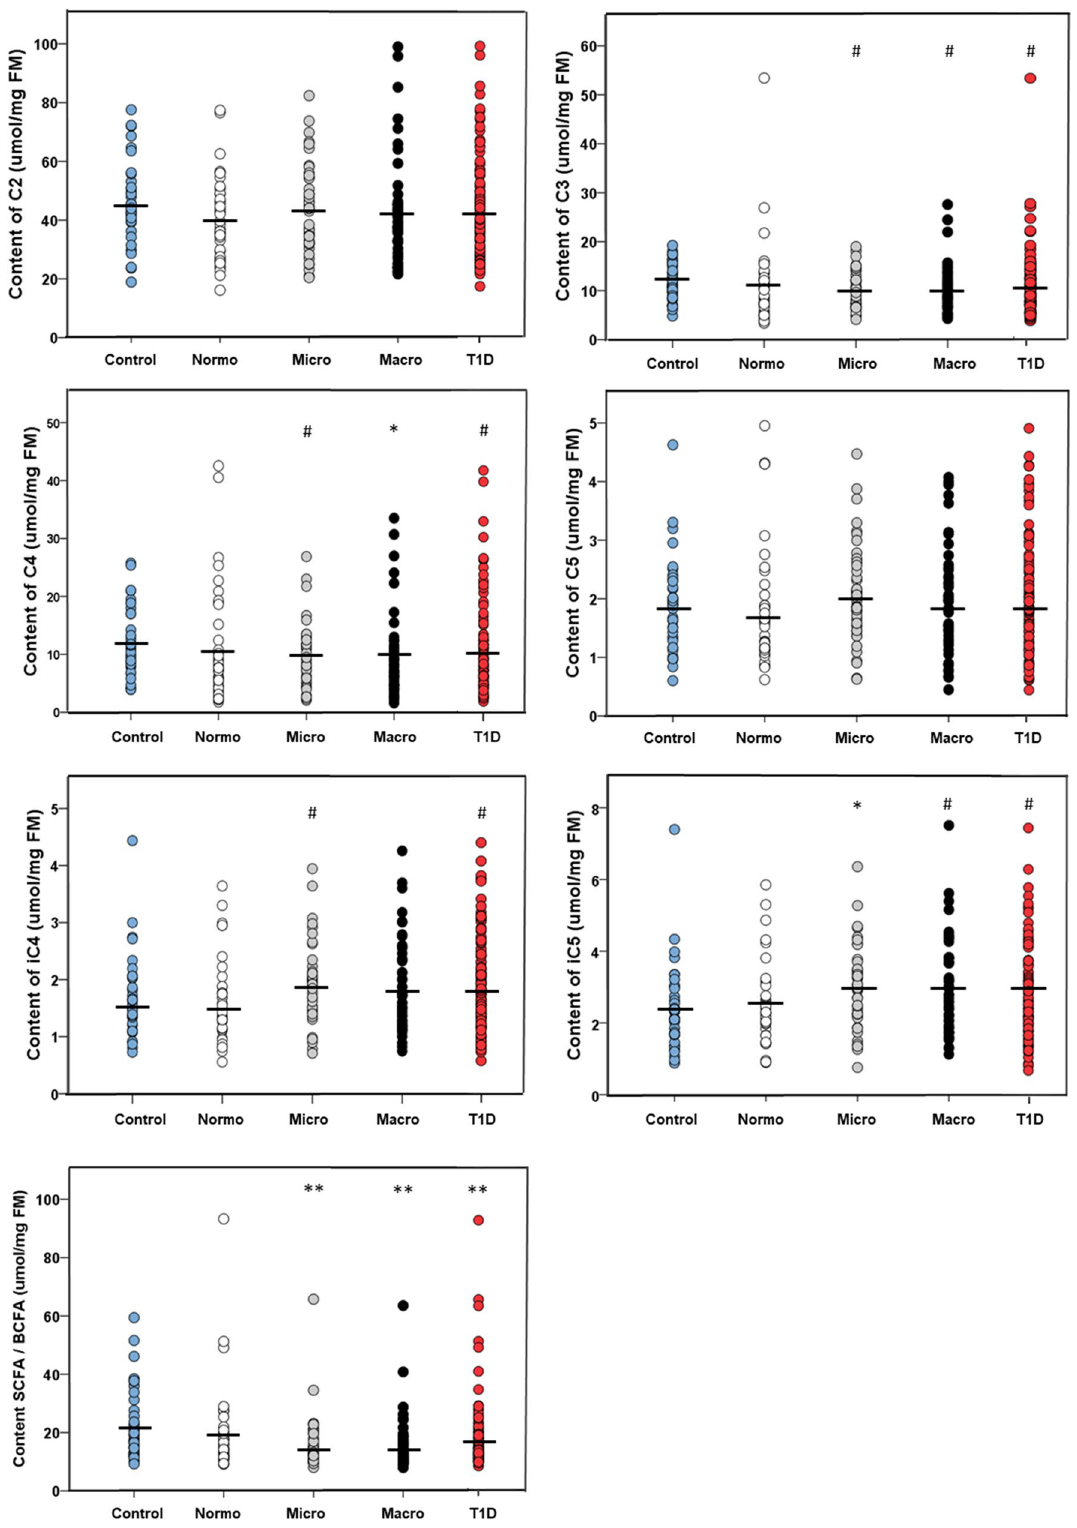
Figure 2. Faecal short chain fatty acids (SCFA). Acetate (C2), valerate (C5), isobutyrate (iC4) and isovalerate (iC5) levels did not differ between subjects with T1D and controls. Propionate (C3) and butyrate (C4) levels and the SCFA/BCFA -ratio were significantly lower among the subjects with diabetes compared to controls. SCFA (sum of C2, C3, C4 and C5), and branched SCFA (BCFA) (sum of iC4 and iC5). Only relevant significances between the controls (n = 40) and disease groups (Normo, n = 40; Micro, n = 42; Macro, n = 50; T1D, n = 132) are shown. # p < 0.05; * p < 0.01; ** p <